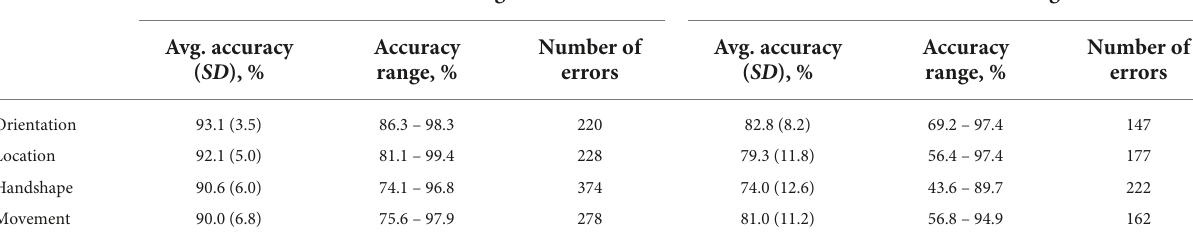
TABLE 3 Accuracy, accuracy range, and number of errors distributed in each parameter. Parameters Feature-based scoring Parameter-based scoring Avg. accuracy Accuracy Number of Avg. accuracy Accuracy Number of ( SD ), % range, % errors ( SD ), % range, %